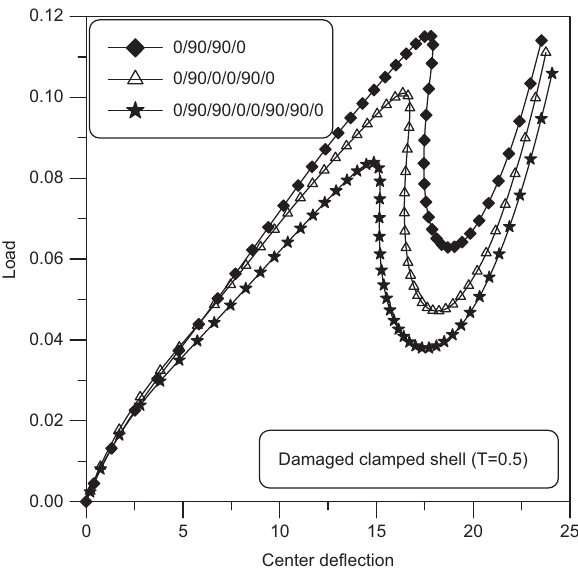
Figure 16 Load-displacement curves of clamped cylindrical shell.